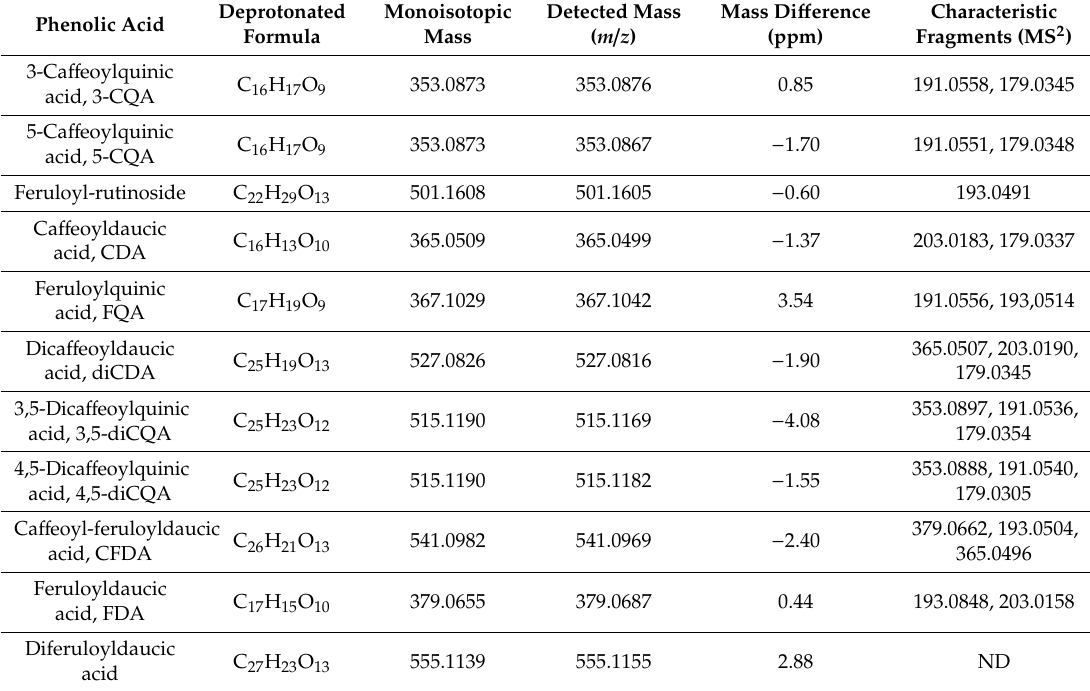
Table 1. MS data of tentatively identified phenolic acids in carrot.